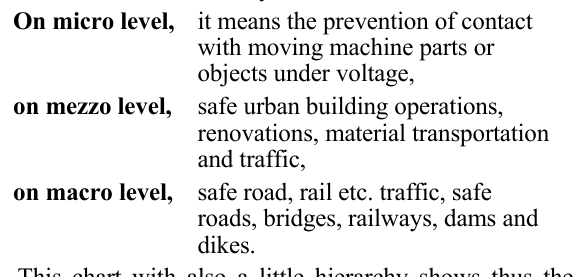
Figure 1. The relationship of Health and Safety to ergonomics, environmental protection, safety engineering and applied medicine Here, I present the media of the ‘material environment’ as the elements of the safety of the